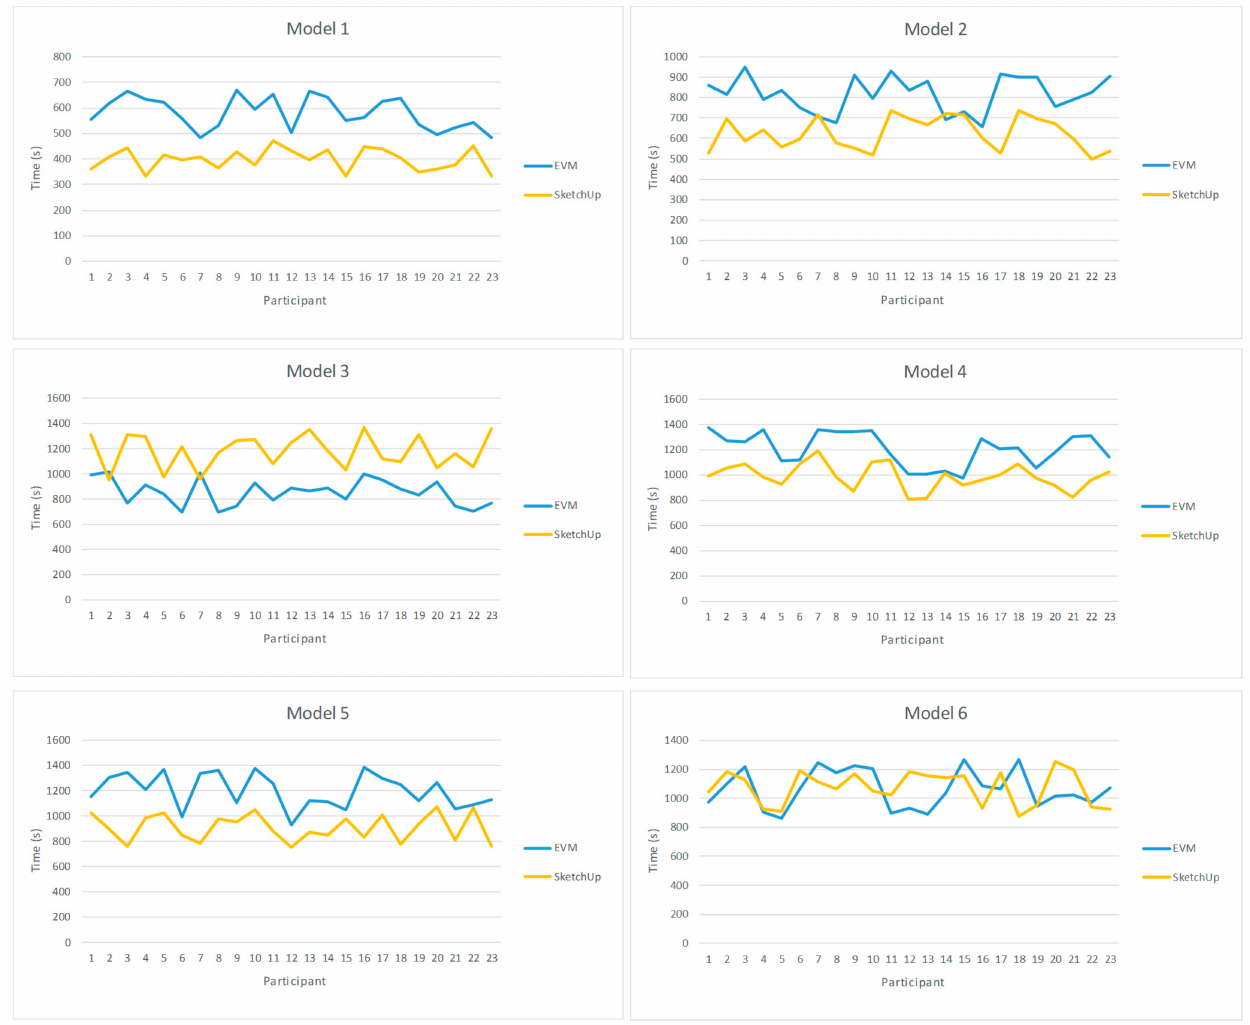
Figure 9. Times employed by the participants to create the six models using SketchUp and